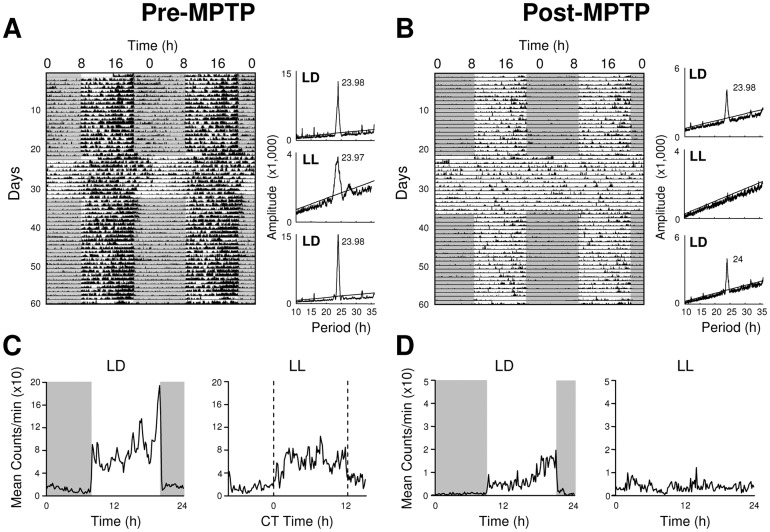
Following MPTP treatment, the circadian locomotor rest-activity rhythm is abolished under constant light.(A) Pre-MPTP treatment, daily locomotor activity is synchronized to the LD cycle (dark phase shown by shading) and in constant light (LL) the circadian rhythm free runs with a period of 23.97 hrs (Monkey Y). (B) Same animal, 4.8 months post-MPTP treatment, rest-wake activity is synchronized to the LD cycle but becomes arrhythmic in LL. Compared to pre-treatment, periodogram analyses (panels to right of actograms) confirm a quantitative decrease in amplitude during LD and the absence of rhythmicity during LL. The averaged 24 h locomotor activity profiles (C–D) illustrate the consolidated activity during the light phase in LD cycle both pre- and post-MPTP and during LL pre-MPTP but a complete loss of rhythmicity post-MPTP.